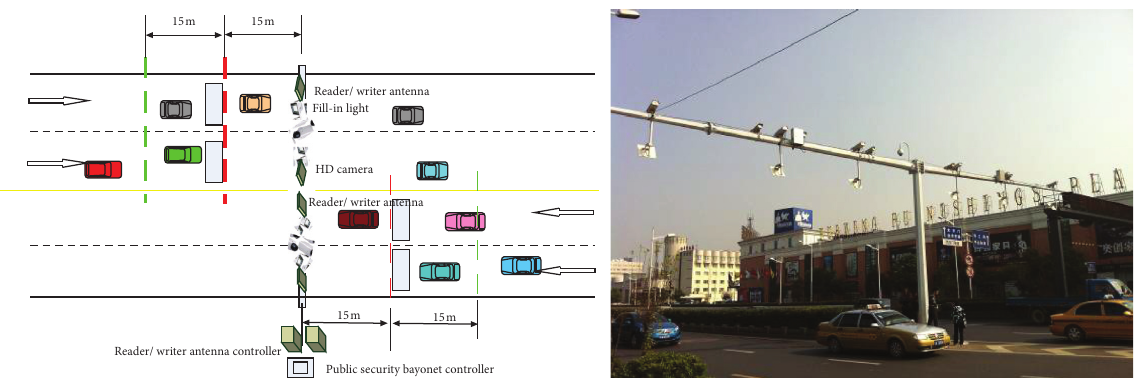
Figure 1: Comprehensive layout diagram and actual installation